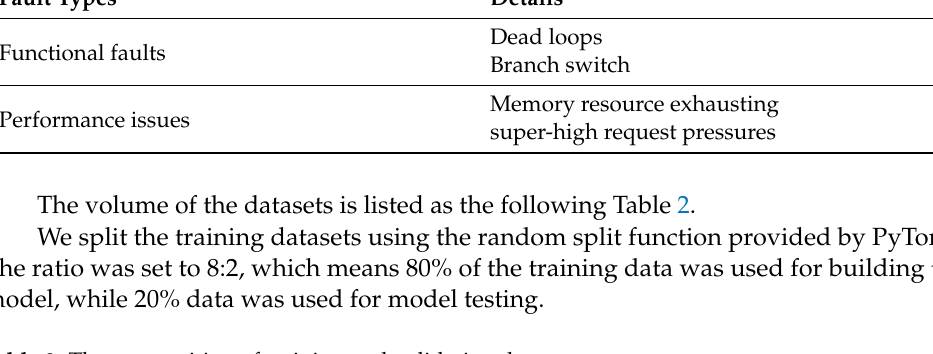
Table 2. The composition of training and validation